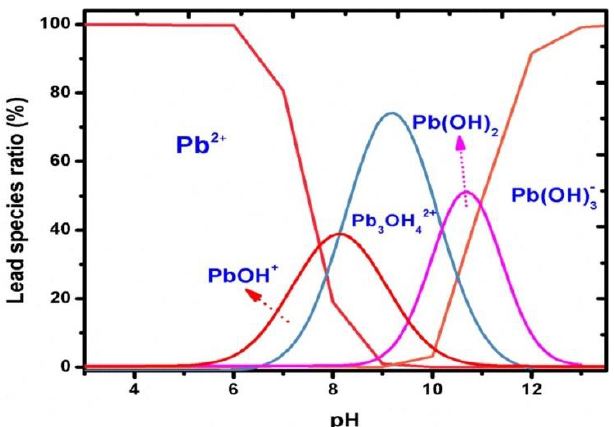
Figure 7. Distribution of the lead species as a function of pH presented by Qureashi et al. [56]. Figure is adapted from reference [56] with permission from Elsevier. is adapted from reference [56] with permission from